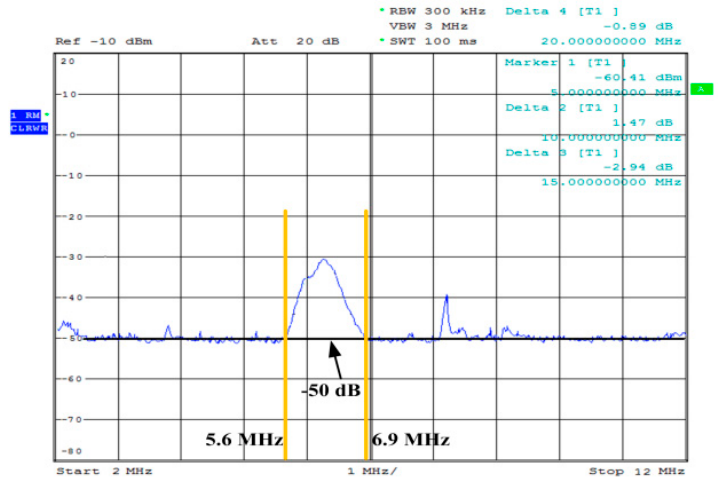
Figure 13. Photograph of the transmission gain at the communication frequency.